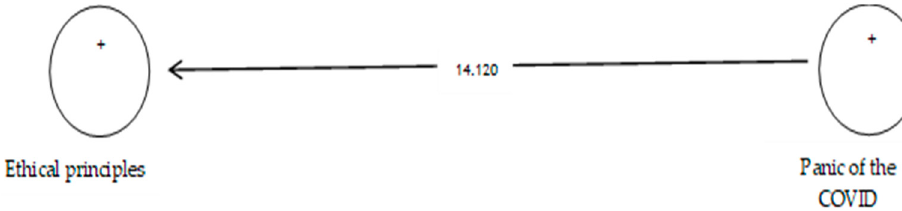
Figure 15. Drawn model with significant coefficients z. Table 10. Evaluation indicators of the internal model of the research, direction and significance of direct effects.